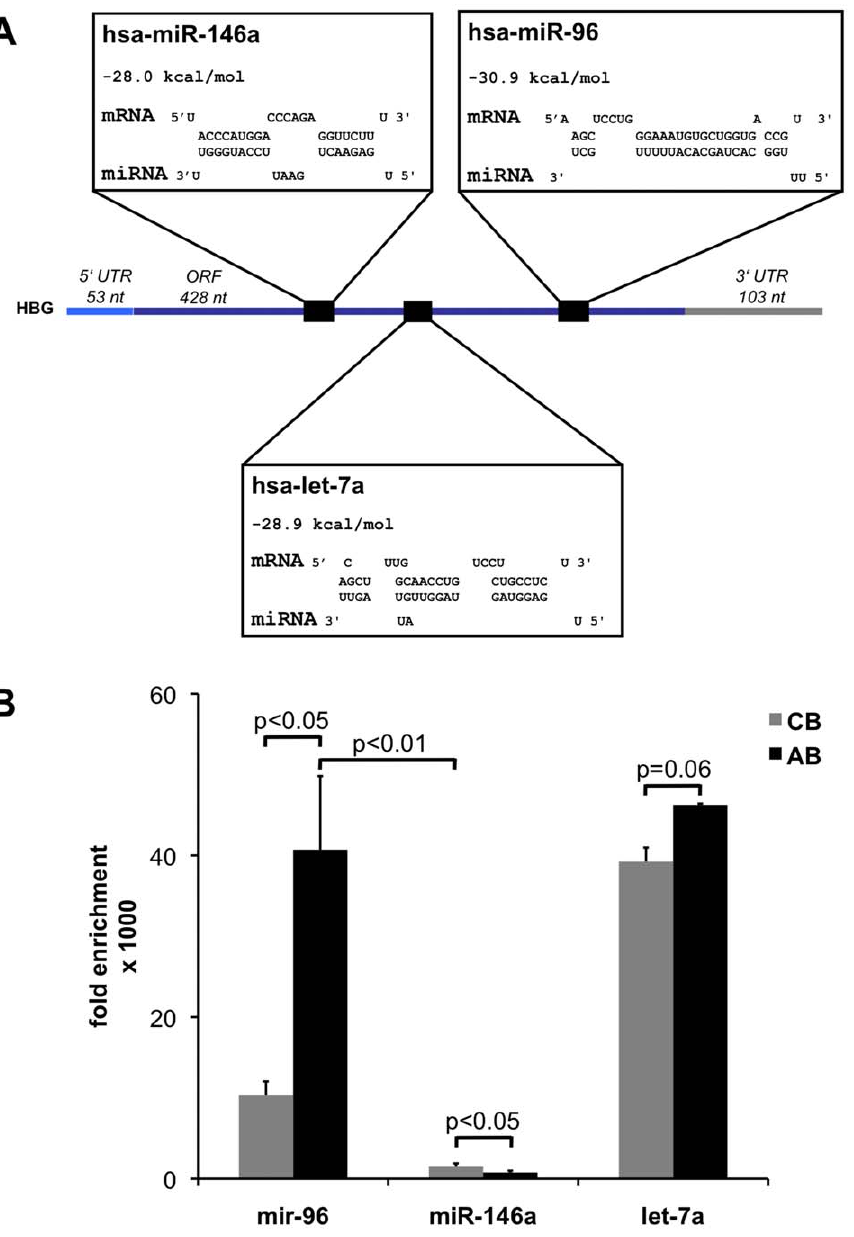
Figure 3. miR-96, miR-146a, let-7a are predicted to target the open reading frame of the c -globin mRNA. (A) Represented are the 5 9 untranslated region (5 9 UTR, light blue), open reading frame (ORF, dark blue) and 3 9 UTR (gray) of c -globin mRNA (HBG). By using RNA hybrid [32], the free energy of the individual miRNA:mRNA hybridization was determined and the corresponding base pairing shown. The hybridizations of c -globin mRNA with miR-96, miR-146a and let-7a (black squares) showed either well-defined mRNA:miRNA pairing (miR-146a and let-7a) consisting of a seed region containing eight base pairs, followed by a four-base pair bulge region and a 3 9 complementary region as described [11] or seedless base pairing (miR-96), all within the open reading frame (ORF) of HBG. (B) The amounts of miR-96, miR-146a and let-7a immunoprecipitated together with AGO2 from CB and AB were compared to amounts of miR-96, miR-146a and let-7a that were non-specifically immunoprecipitated with control IgG. For every sample the same amount of precipitated RNA was analyzed. The values are expressed as 1000-fold-enrichment over IgG immunoprecipitations, and represent mean 6 SEM (n=3). P values were determined by the Student’s t-test.